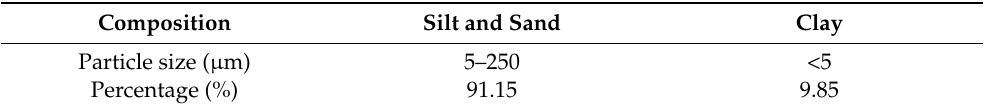
Table 4. Granulometrical analysis of <0.25 mm fraction of stream sediments. Composition